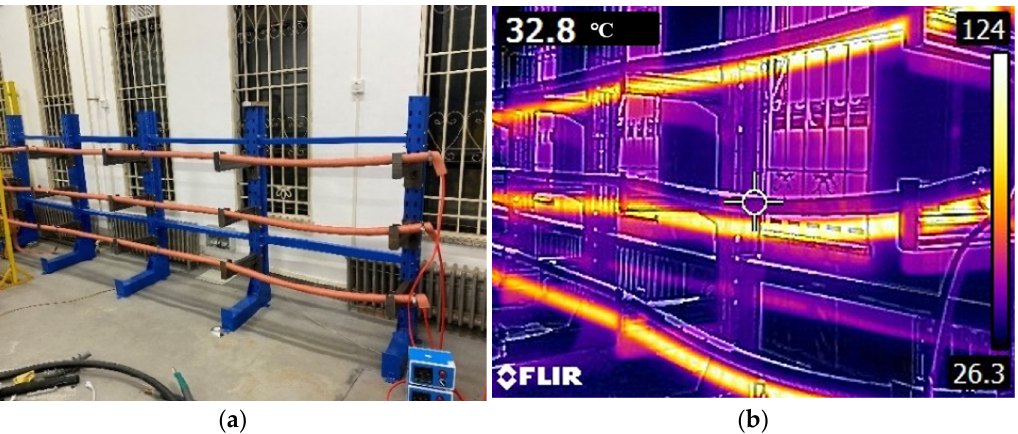
Figure 4. Physical picture of the heating platform and the infrared thermal image: ( a ) Physical picture of heating platform; ( b ) The infrared thermal image.